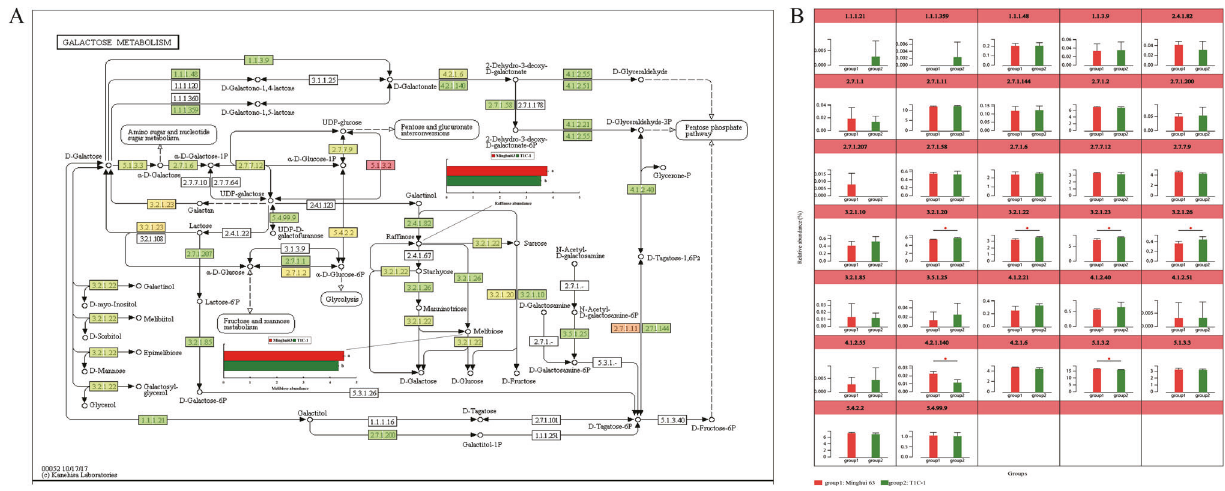
Fig. 6 Differentially enriched KEGG pathways revealed by combined ‘ omics ’ analyses. KEGG enrichment pathways identi fi ed as differential between T1C-1 and Minghui 63 communities based on rhizosphere metabolomic ( A ) and metagenomic ( B )